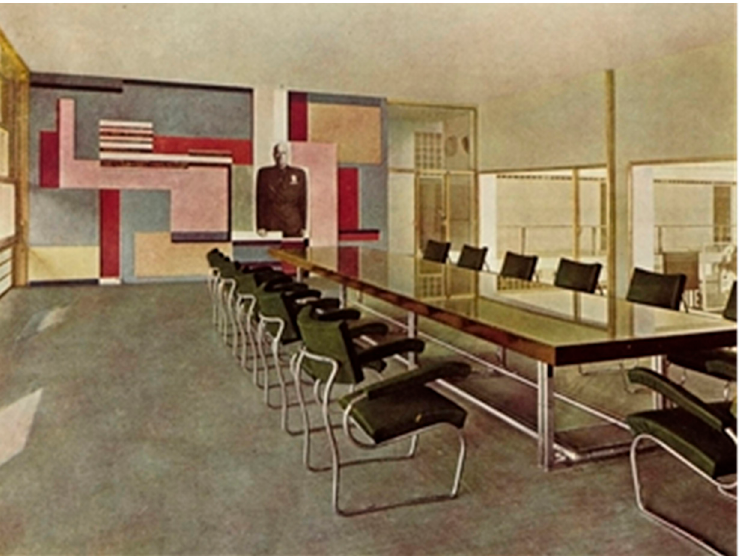
Figure 25. Casa del fascio by Giuseppe Terragni. Como (1932–1936). Directory room, table in chromed alpaca stiffened with anticorodal tubular. Top protected by glass sheet 140 cm × 700 cm, thickness 10 mm. Fresco by Mario Radice. Armchairs model “Benita”. Table and armchairs produced by the company Columbus. Photo from (Sartoris 1941, p. 398).